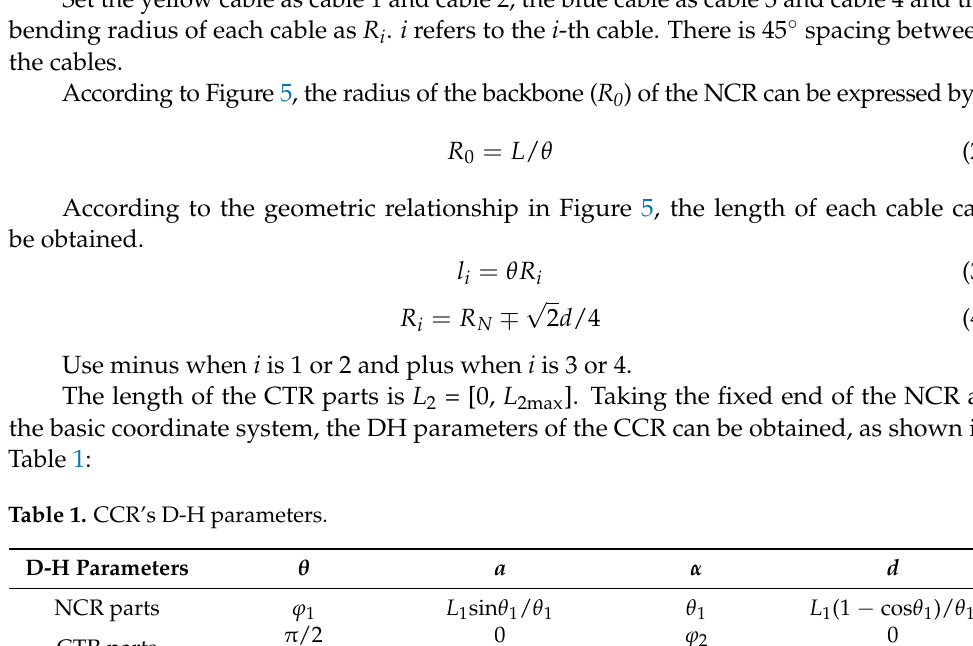
Figure 4. The backbone curve and coordinates of the CCR.